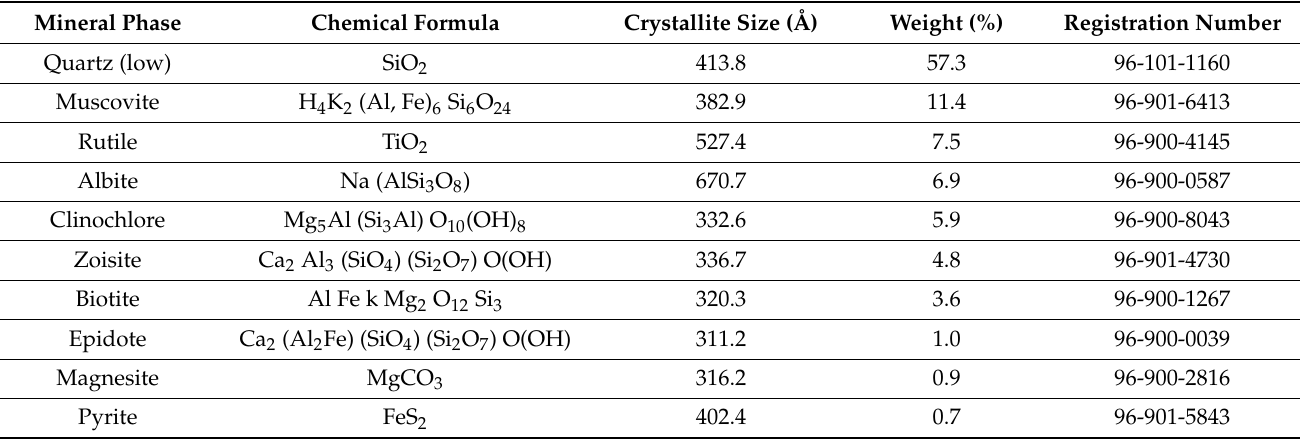
Figure 10. Results of petrographic analysis for microschist sample at 800 °C (S3), images ( a , b ) display fine-grain laminated texture of microschist, and images ( c , e ) (PPL) show epidote (EP), opaque grains (Opq), and grain deformation. It is predominantly composed of microcrystalline quartz (Q), together with pale-green chlorite (Chl), epidote (Ep), and a platy, dark opaque-like mineral (rutile or biotite) plus opaque grains (iron sulfide). Images ( e , f ), having an analogous texture with images ( a – d ), were taken from the slightly reddish zone of the thin section. Images ( d , f ) display the presence of a few brownish to reddish platy grains (rutile or biotite) that locally give the reddish-brown coloration to the rock assemblage. Table 2. Mineral phases, crystallite sizes, weight percentage, and registration numbers of minerals in the studied microschist at room